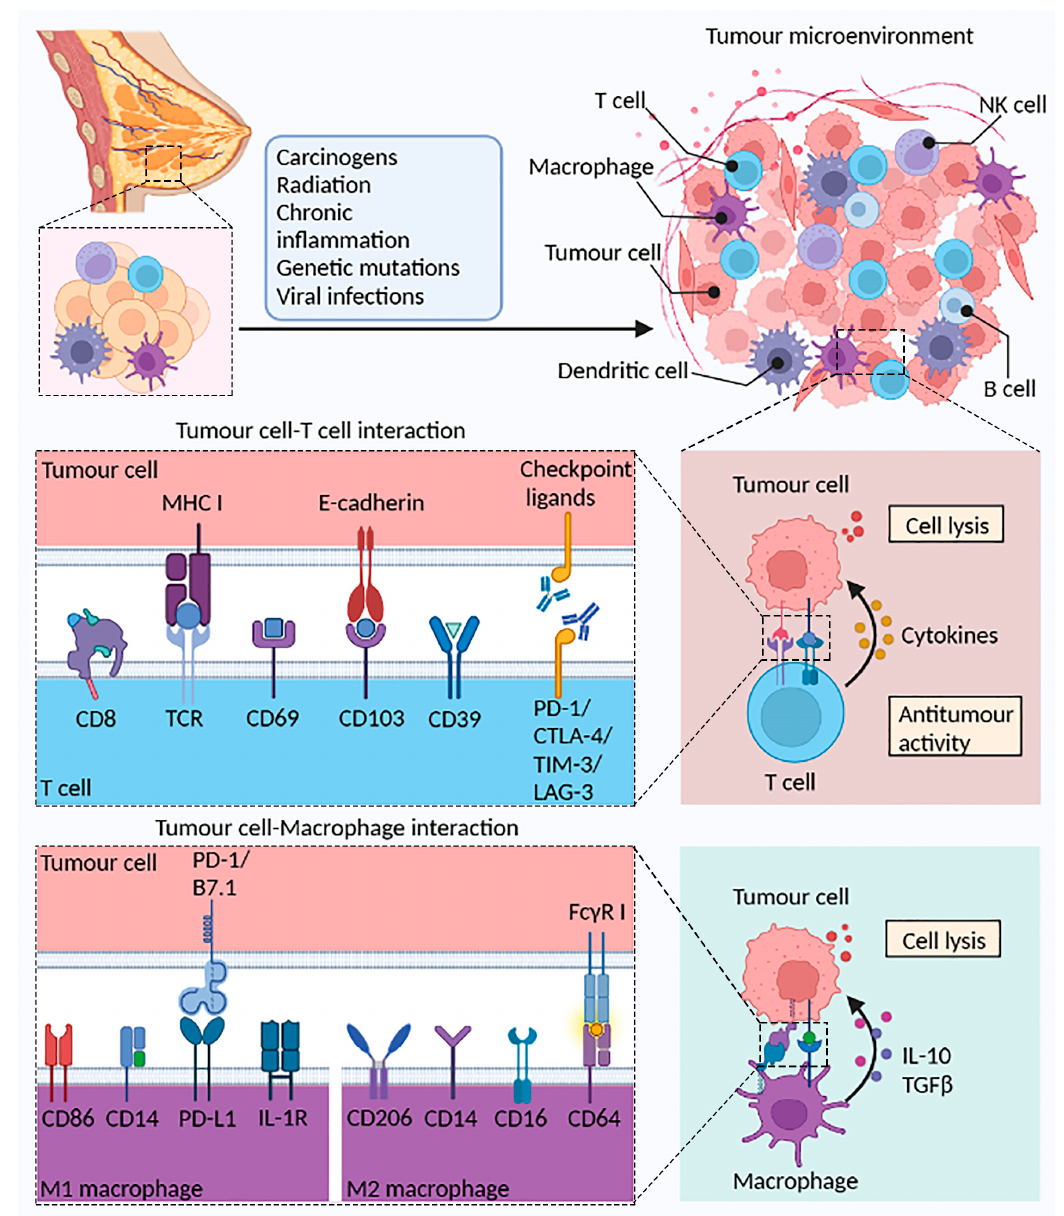
Figure 1. The potential role of T cells and macrophages in the TME. Normal breast tissue can become cancerous after stimulation by radiation, chronic inflammation, or viral infection. A variety of im- mune cells (B cells, T cells, macrophages, and DCs) elicit the body’s antitumor immune response through different mechanisms. Tumor debris generated by tumor cell death is phagocytosed and processed by DCs to present antigens to T cells, activate CD4 + Th1 cells via IFN- γ , and finally acti- vate CD8 + CTL cells. In the tumor immune microenvironment, CD103 binds to tumor cells express- ing E-cadherin, reinforcing the establishment of the link between immune cells and tumor cells. T cells highly express immune checkpoint proteins such as PD-1, CTLA-4, TIM-3, and LAG-3, which prevent tumor immune escape upon binding to the corresponding ligands on tumor cells. Addi- tionally, increased presentation of tumor-associated antigens (TAAs) promoted the activity of M1 macrophages and upregulated the antitumor immune response. Reprinted/adapted with permis- sion from Created with BioRender.com. 3.3. Immunosurveillance and Immunoediting in Breast Cancer Since Paul Ehrlich established the notion of possible immune suppression of carci- noma more than a century ago, the role of the immune system in cancer has been a con-